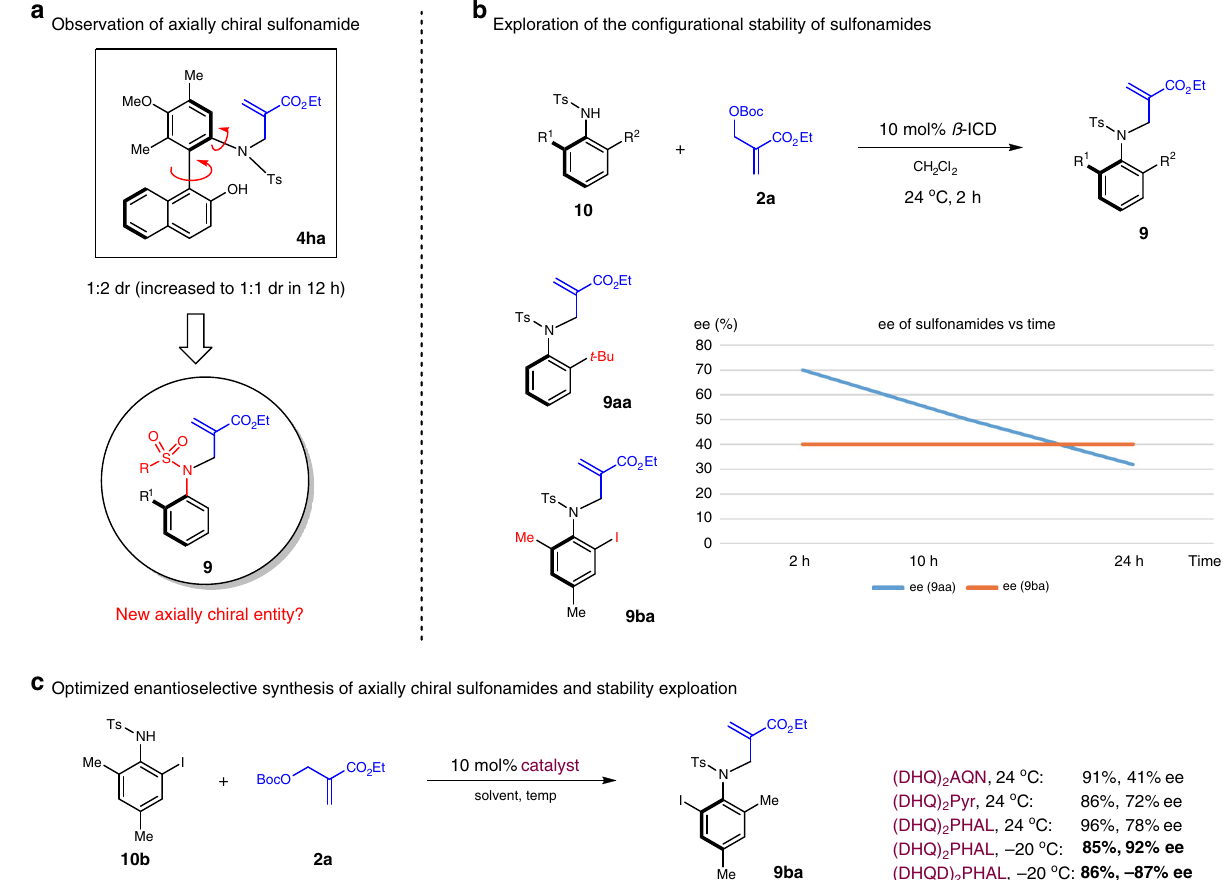
Fig. 4 Discovery and exploration of axially chiral sulfonamides. a Observation of axial chirality in N-aryl sulfonamide. b Exploration of the stability of axial chirality. c Optimization of atroposelective sulfonamide